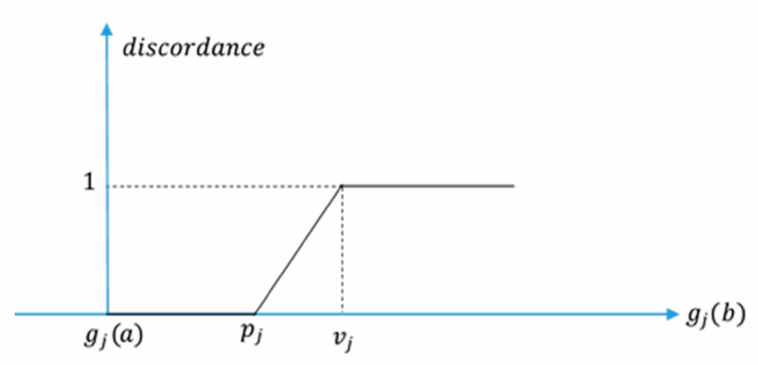
Figure A1. Preference function in ELECTRE